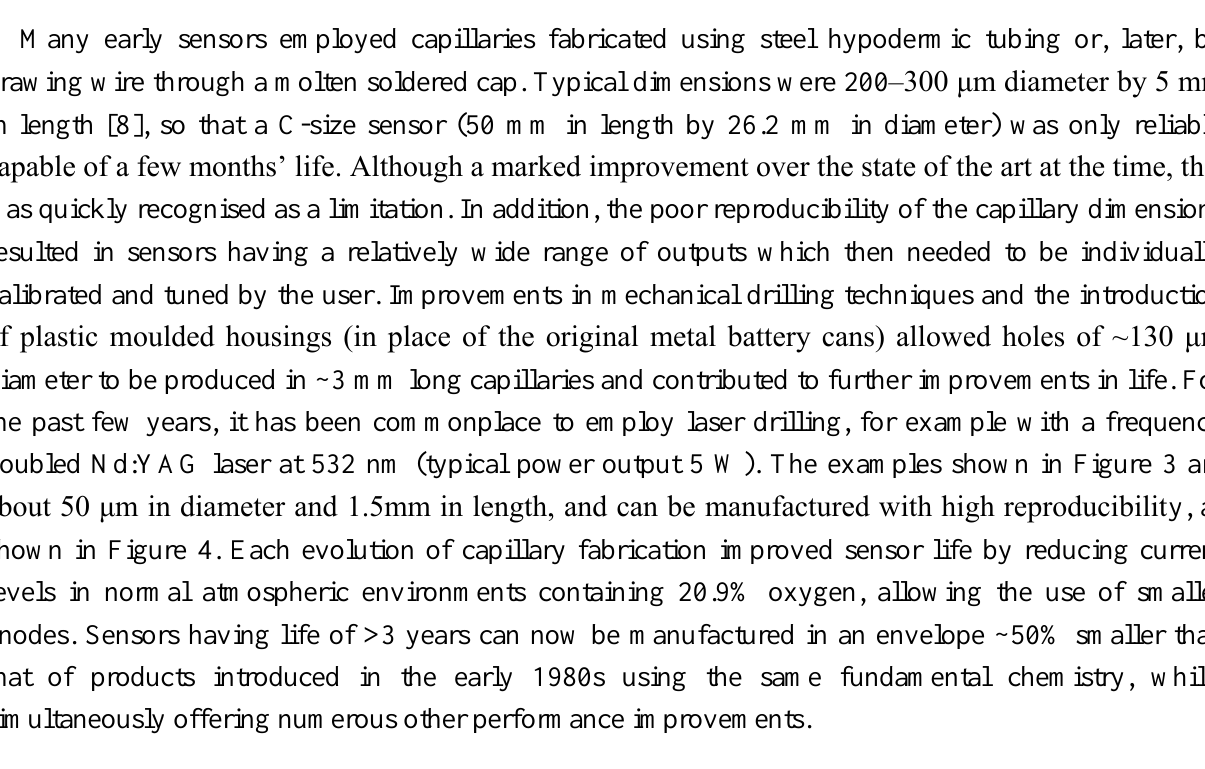
Figure 3. Example entry aperture ( a ) and cross section ( b ) of laser drilled capillary diffusion barriers for oxygen